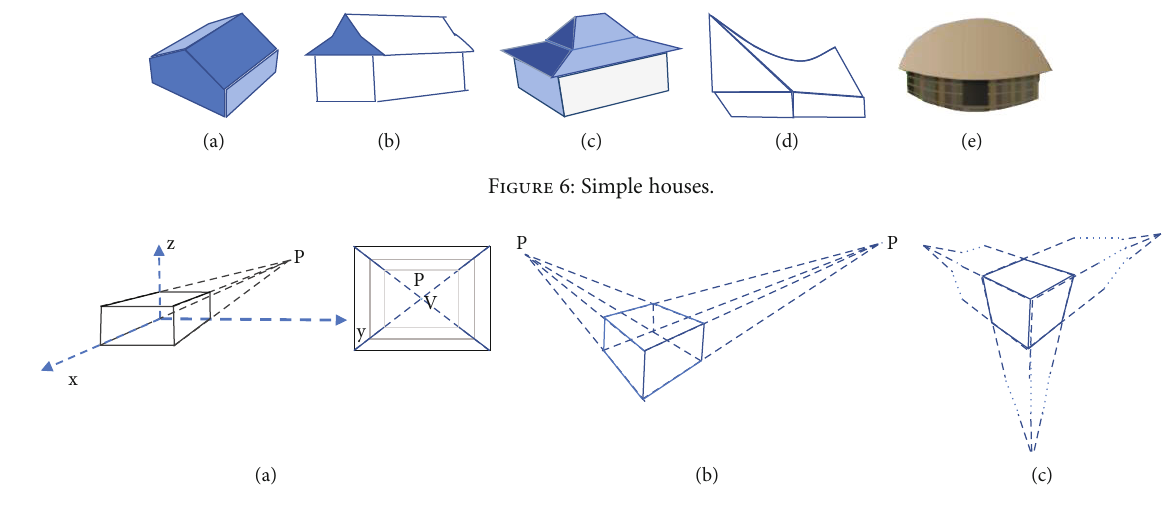
Figure 7: (a) One vanishing point; (b) two vanishing points; (c) three vanishing points.